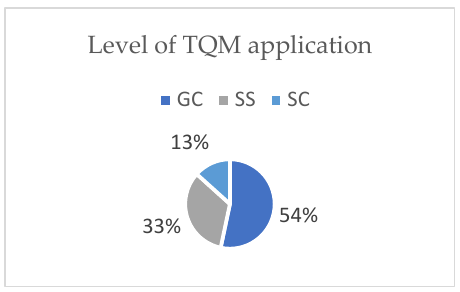
Figure 5. Level of TQM application (own study).